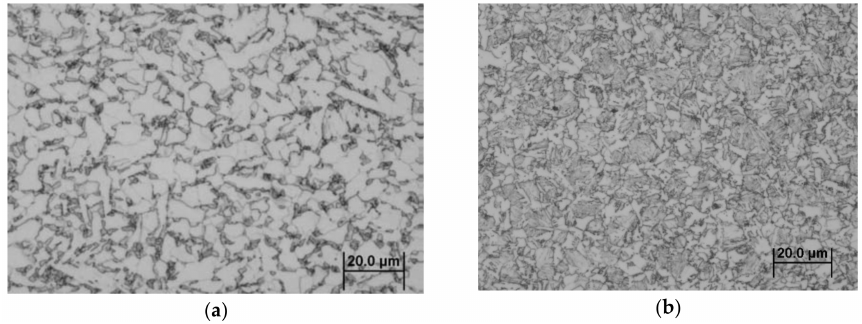
Figure 6. The microstructure of material C after annealing: ( a ) DPC 750 ; ( b ) DPC 820